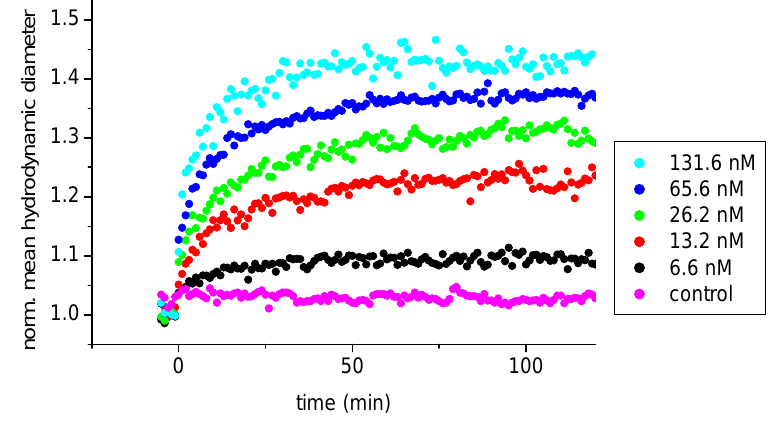
Figure 4. Normalized mean hydrodynamic diameter determined by monoexponential fit of relaxation data of the interaction between anti-IGF-1-MNPs and IGF-1 in different amounts. Control: 3 nM